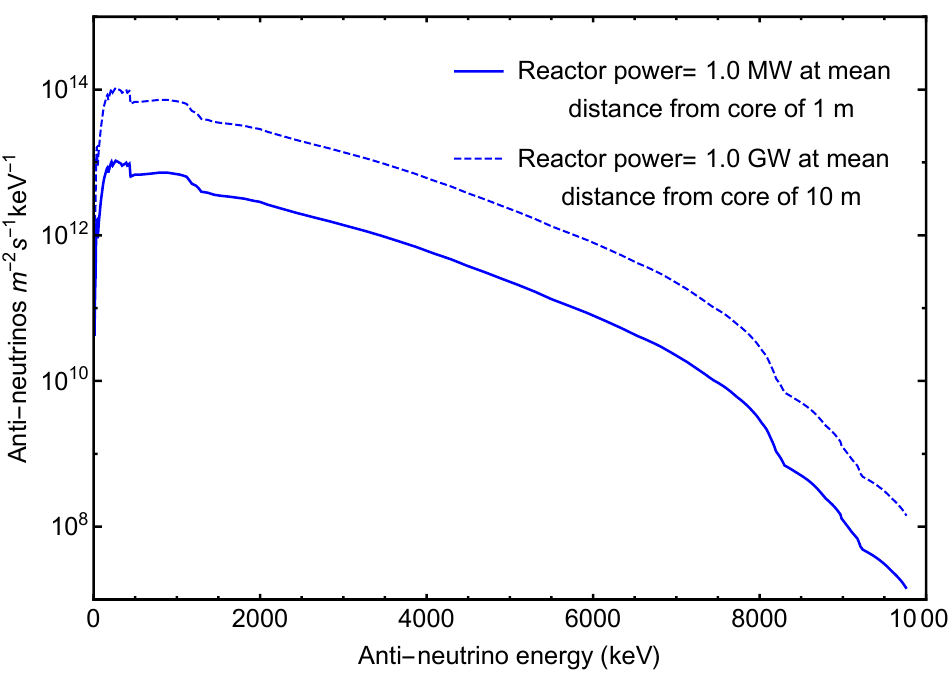
Figure 1 . Anti-neutrino spectrum produced in the nuclear fission process at reactor based neutrino experiment. We use the spectrum corresponding to 1 MW power reactor with core to detector distance 1 meter (solid line). We also show that, by using a 1 GW power reactor with core to detector distance 10 meters, we can get one order of magnitude more flux (Dashed